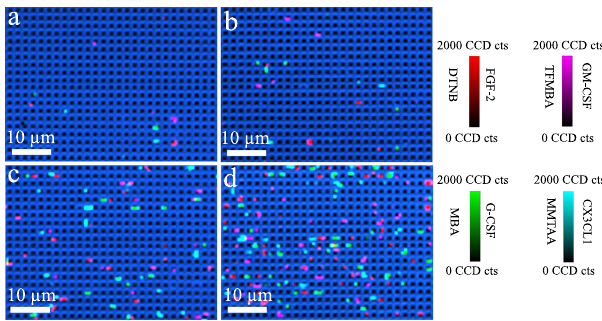
Fig. 6 Sensitivity for the simultaneous detection of four